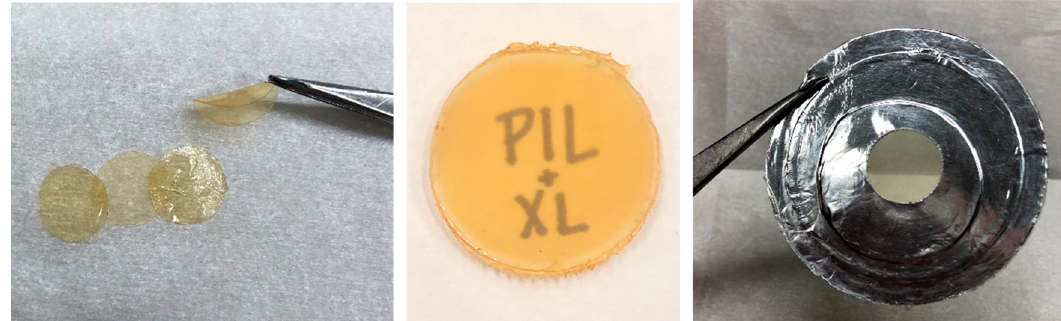
Figure 3. Transparency and flexibility of [C 4 vim][Tf 2 N] composites with imidazolium-benzene fillers (left); increased rigidity and opacity of [C 4 vim][Tf 2 N] composites with [Tri(VinylIm + )XL ][Tf 2 N] (right, as masked membrane) or [Tet (VinylIm + )XL ][Tf 2 N] (center, as punched disk).